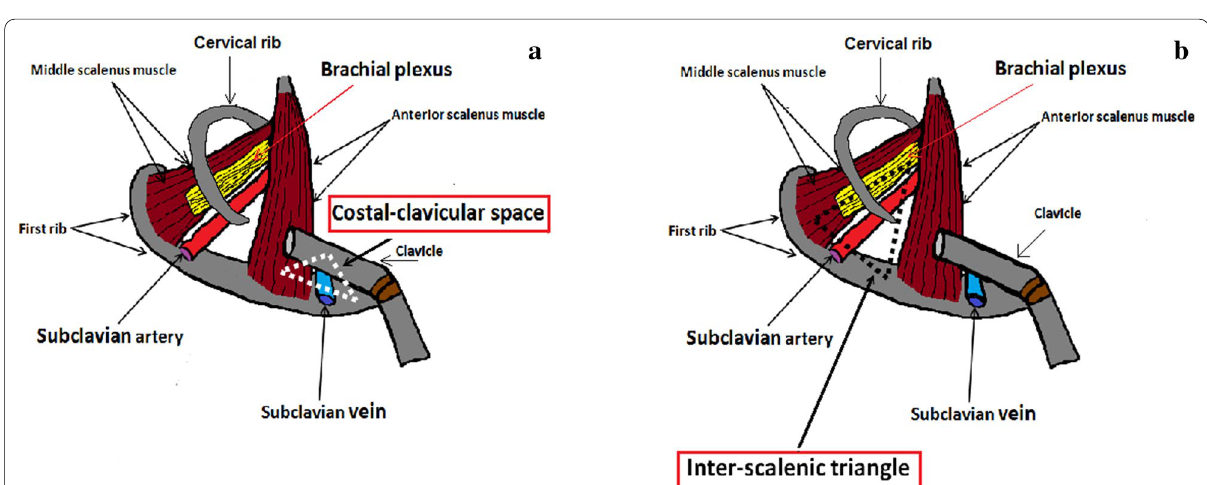
Fig. 2 Scheme summarizing the anatomical relationships between the shoulder structures in TOS. a Cost-clavicular space delimited inferiorly by first rib, superiorly by clavicle, and anteriorly by anterior scalene muscle. b Inter-scalene triangle delimited inferiorly by clavicle, medially by anterior scalene muscle, and laterally by middle scalene